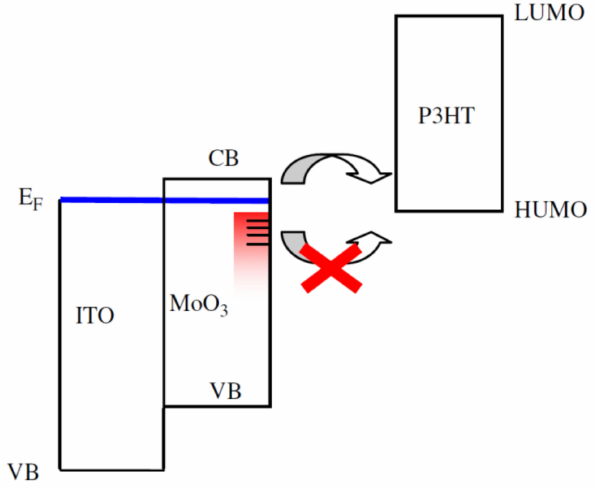
Figure 4. Schematics of charge extraction path ways at the anode buffer (MoO 3 ) and P3HT interface. Reproduced with permission from Reference